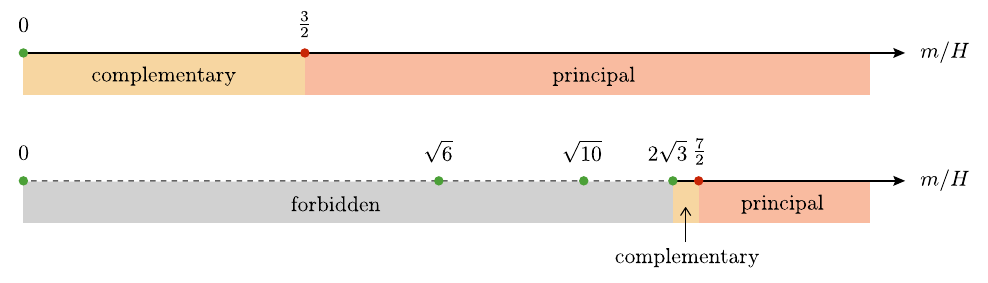
Figure 1 . Spectrum of spin-0 (top) and spin-4 (cid:12)elds (bottom) in de Sitter space. The green points correspond to masses in the discrete